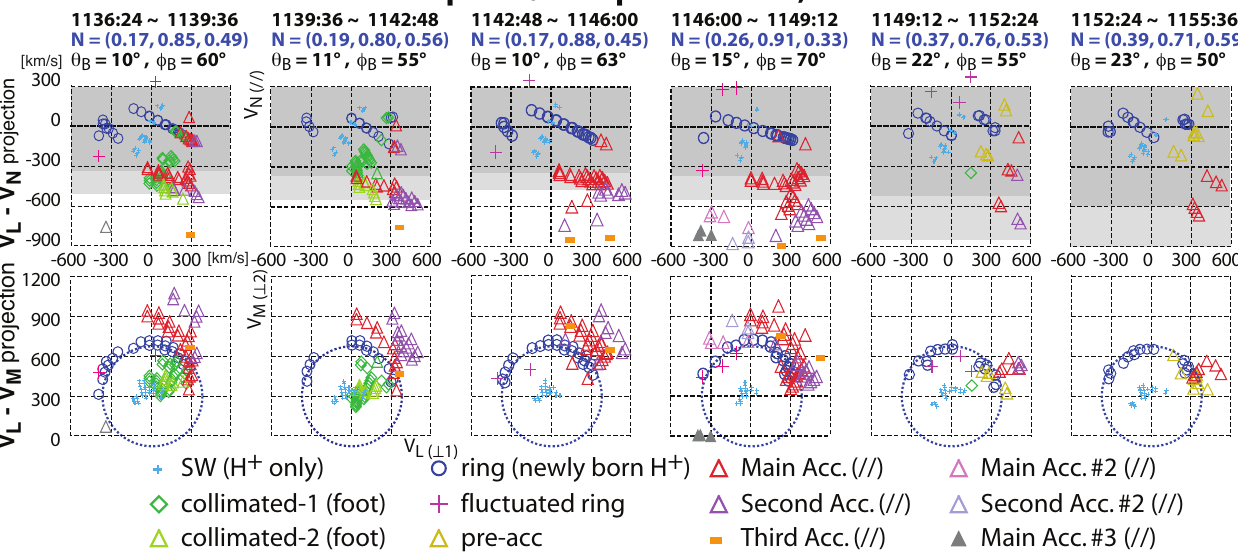
Fig. 8. Velocity scatter plots of the six consecutive scans shown in Fig. 7. The velocity space points with 5 counts or more during the 100ms measurement period are plotted in the spacecraft reference frame (this threshold is increased to 10 counts per 100ms measurement for the solar wind that is marked by light blue pluses). The local Cartesian coordinates L - M - N are derived such that N points along the magnetic field and L X = 0. The estimated N vector values in the MSO coordinate are given at the top of each panel, where θ B is the angle between the N vector and Z , and φ B is the rotation angle of the N vector in the Y - Z plane stating from the Z axis (the same definition as Yamauchi et al., 2006, 2008). The grey-hatched area represents velocity space in which ions have positive V N in locally-defined de Hoffman-Teller frame, where the error bar (hatched by light grey) is defined by assuming the ± 5 ◦ uncertainty in the bow shock normal direction. Identified ion populations use the legend at the bottom. The color-coded symbols corresponds to the color-coded arrows shown in Fig. 7. higher energy than the primary ring distribution (marked red, purple, or orange in Figs. 7 and 8) and a collimated